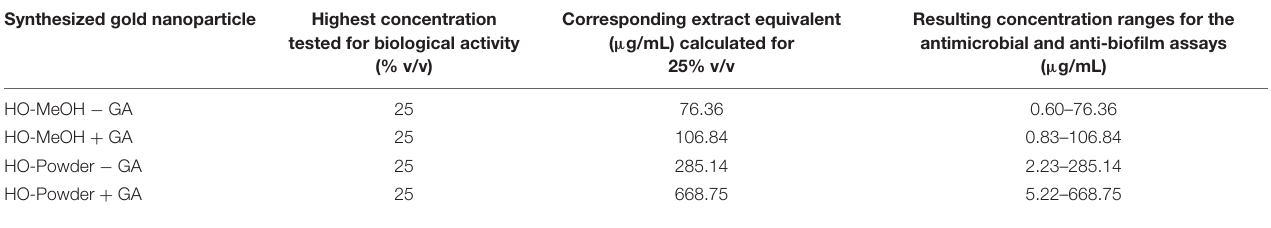
TABLE 1 | Calculation of the total phenolic content of the synthesized AuNPs as extract equivalents for the conversion of concentration represented as % v/v to µ g/mL. Synthesized gold nanoparticle Highest concentration tested for biological